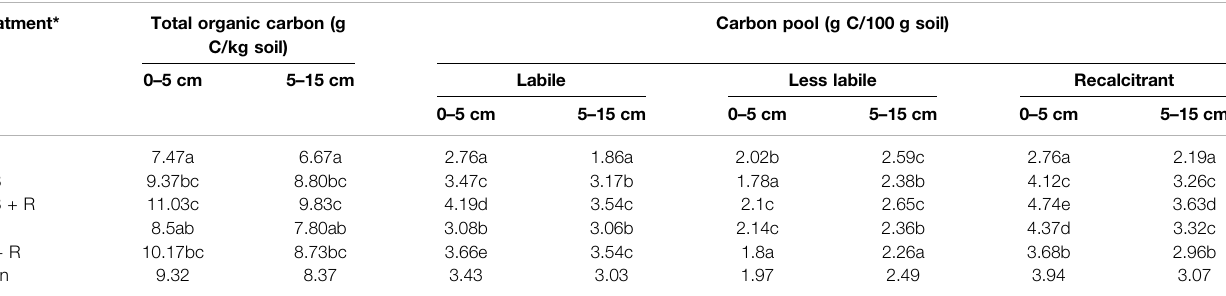
TABLE 2 | Total organic carbon content (g/kg) and organic carbon pools (g/100 g soil) in 0 – 5 and 5 – 15 cm of soil layers. Treatment*